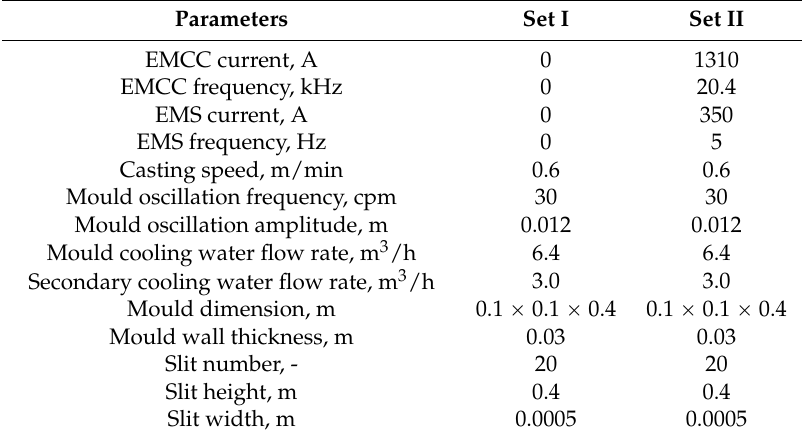
Table 2. Experimental conditions and operating parameters for Set I and II. Parameters Set I Set